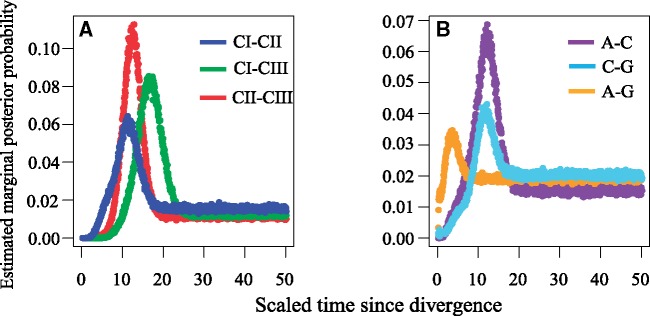
—Marginal posterior probability density distribution of relative divergence times in pairwise comparisons among clades (A) and among subclades in Clade III (B) of symbiotic genes estimated using IMa2. Smaller means and modes of the scaled time since divergence indicate more recent divergence of clades/subclades.